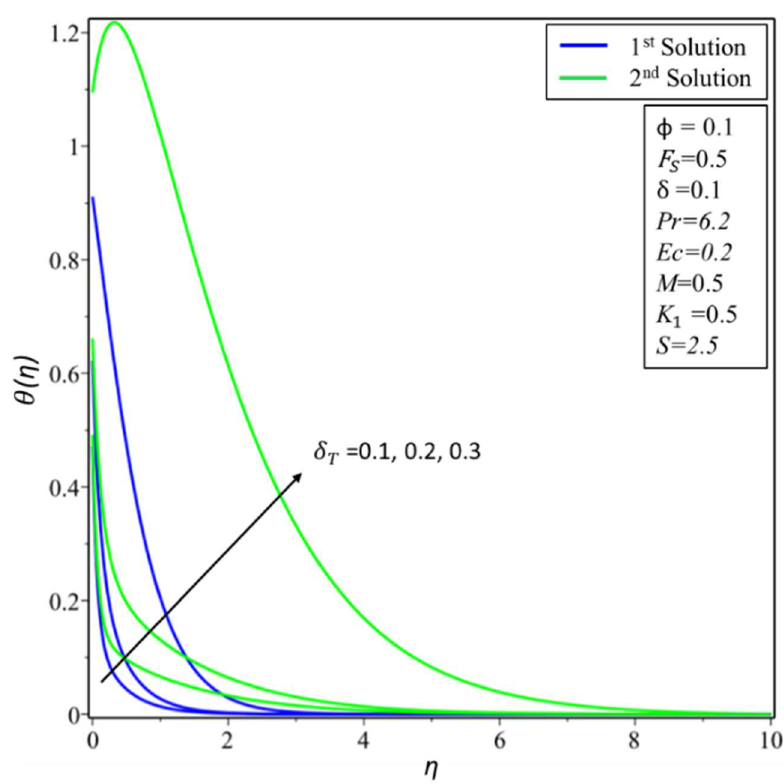
Figure 9. Changes of θ ( η ) for δ T .